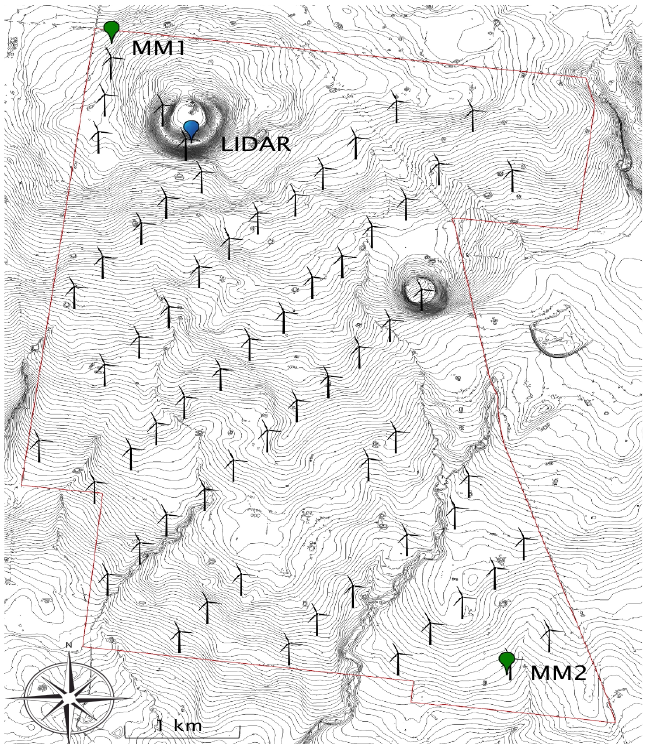
Figure 3. Mount Mercer wind farm location plan. The location of the 64 turbines, 2 met masts, and the LiDAR are designated by the turbine symbols and green and blue markers, respectively. Site boundaries are shown in red. Topography lines (1m contour interval) are shown in